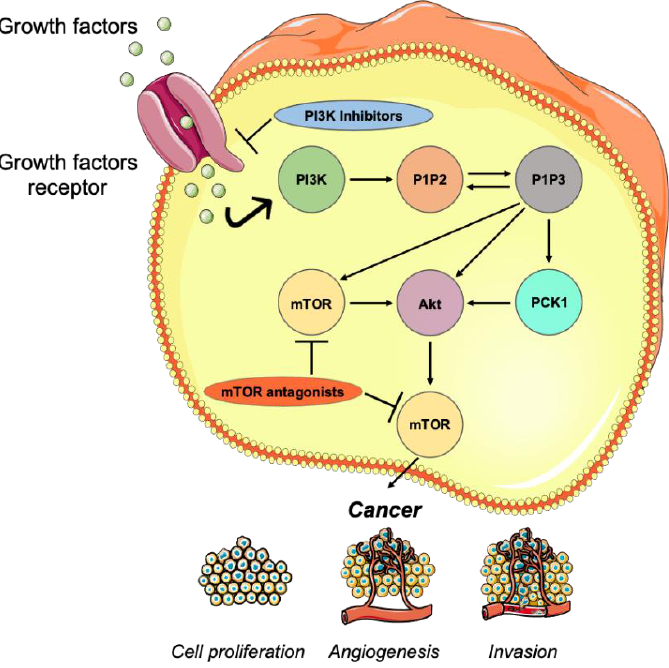
Figure 3. PI3K/Akt/mTOR pathway as a therapeutic target against triple-negative breast cancer.